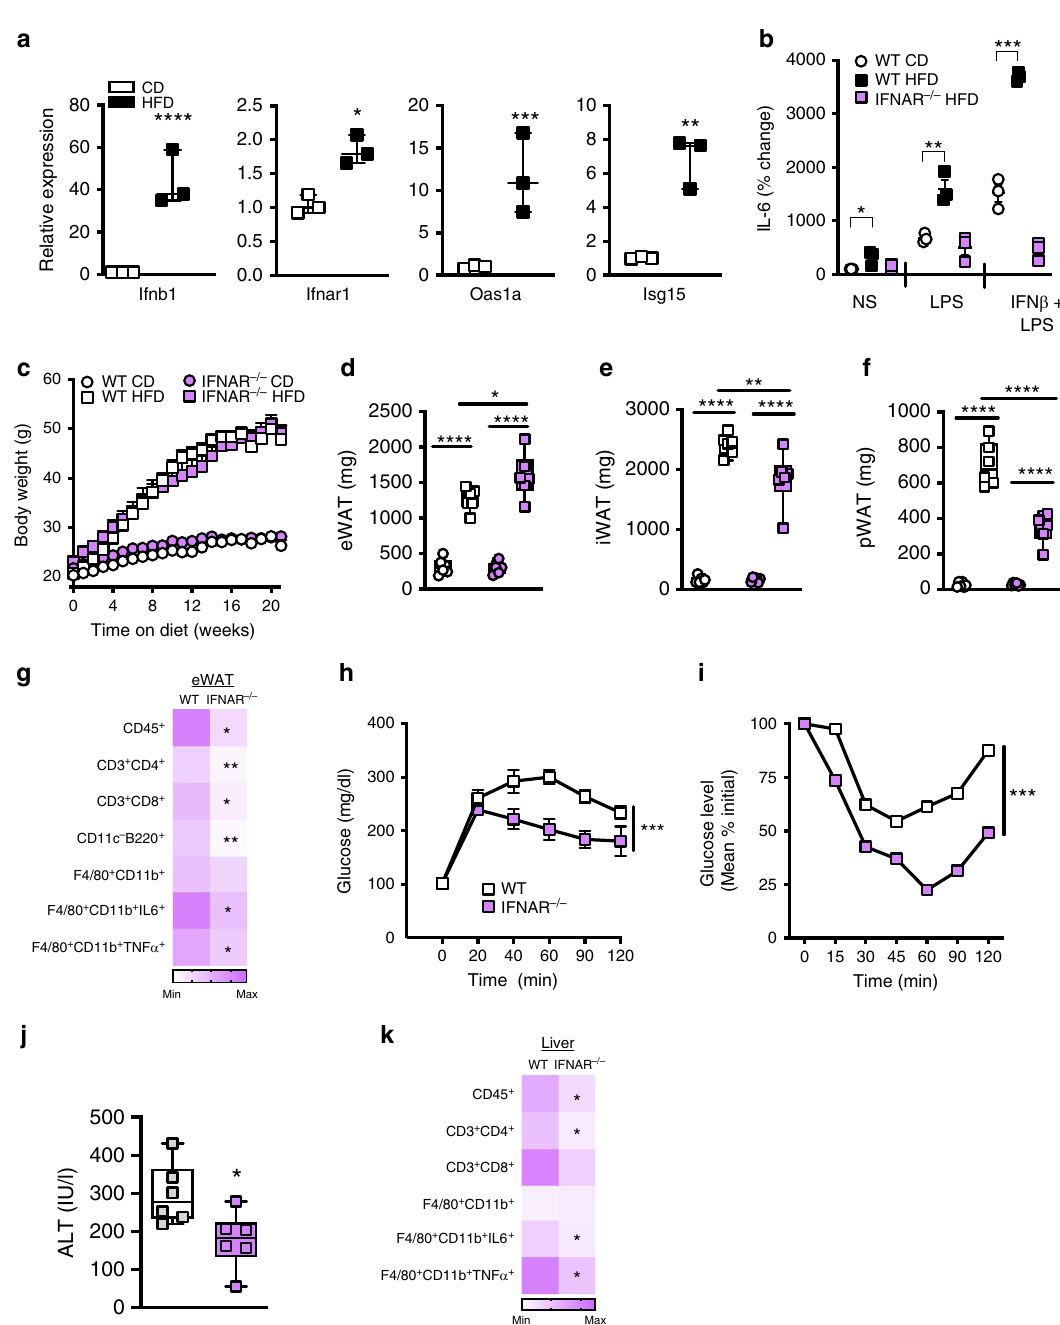
Fig. 4 Type I IFN/IFNAR axis contributes to the pathogenesis of obesity-associated sequelae. a , b Adipocytes were isolated from WT mice placed on a high-fat diet (HFD) or low-fat chow diet (CD) for 8 weeks. a mRNA expression of the indicated type I IFN axis genes by qPCR in primary adipocytes, relative expression to CD. b Primary adipocytes treated with saline (NS), IFN β (250 U/ml) or LPS (100 ng/ml) as indicated and IL-6 protein levels in supernatant were quanti fi ed by ELISA; % change over NS. c − k WT and IFNAR − / − mice were fed HFD for 22 weeks. c Total body weight over time. d eWAT, e iWAT, f pWAT weights. g Average eWAT immune cell in fi ltration measured by fl ow cytometry. h Glucose and i insulin tolerance tests. j Systemic alanine transaminase (ALT) quanti fi ed at time of harvest. k Average liver immune cell in fi ltration measured by fl ow cytometry. a , b Representative of two independent experiments, n = 3/condition. c − k Representative of three independent experiments, n = 6 − 7/condition. a , b , d − f , j For box plots, the midline represents the mean, boxes represent the interquartile range and whiskers show the full range of values. c , g , h − I , k For line graphs and heat maps data represent mean ±SEM. a , b , d − g , j , k Unpaired two-tailed Student ’ s t test. * P < 0.05, ** P < 0.01, *** P < 0.001, **** P < 0.0001. c , h , i Area under curve. *** P < 0.001. Source data are provided as a Source data fi IFNAR − / − mice, lack of IFNAR signaling reduced percent of Table 1) and expression of the T- and B-cell chemoattractants (T cells: Cxcl10, Cxcl9; B cells: Cxcl13 and Ltb4r ) (Supplemen- macrophages producing proin fl ammatory cytokines central to tary Fig. 8). Although the total number of eWAT in fi ltrating obesity pathogenesis 5 (IL-6 and TNF; Fig. 4g; Supplementary Fig. 7; Supplementary Table 1). macrophages (F4/80 + CD11b + ) was similar between WT and